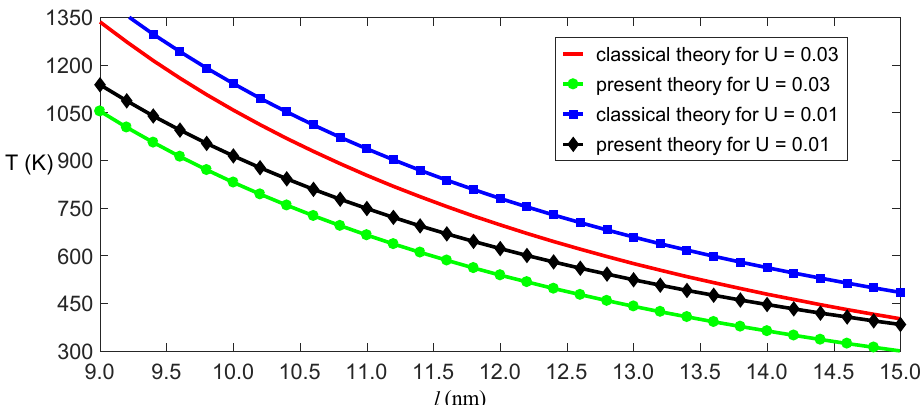
Figure 4. Critical temperature as a function of critical length for the given critical electric fields.